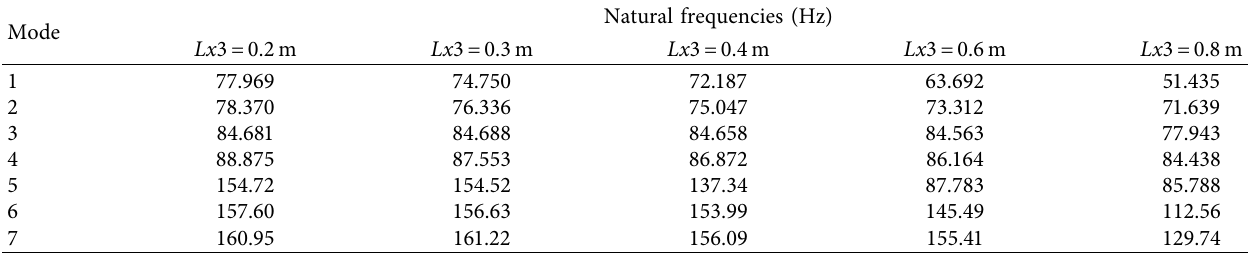
Table 4: First seven natural frequencies of the stiffened double panel-cavity coupled system with different lengths of the stiffener. Mode